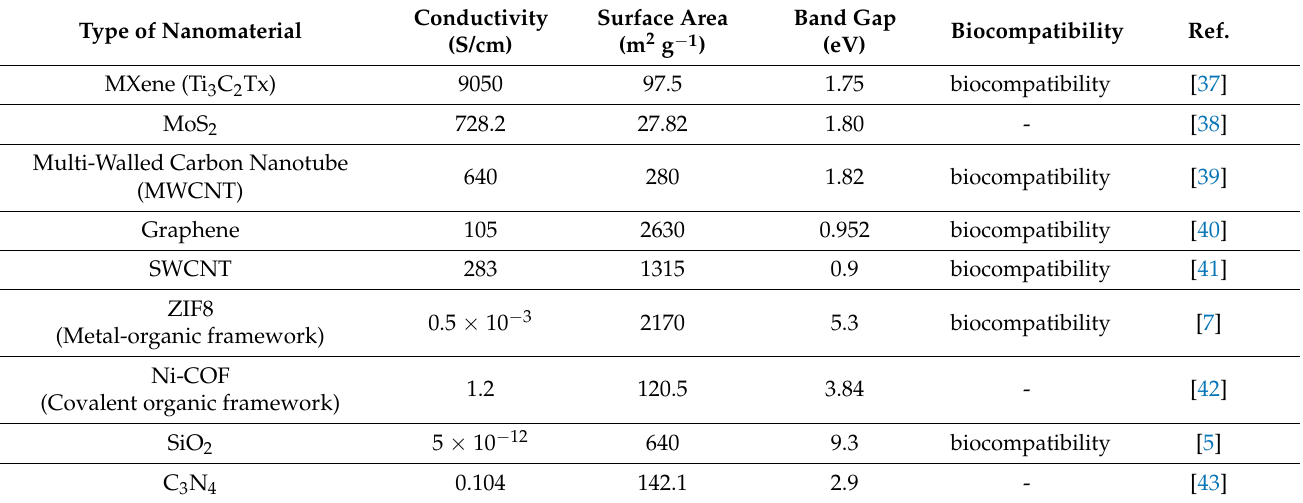
Table 1. Comparison of the physicochemical properties of MXenes with other nanomaterials. Type of